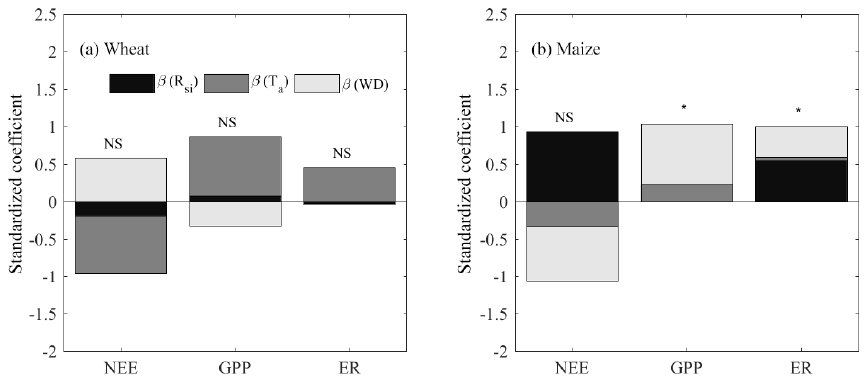
Figure 8. The result of multiple regression for NEE, GPP and ER with incoming shortwave radiation ( R si ), air temperature ( T a ) and ground- water depth (WD) for both (a) wheat and (b) maize. Note that ∗ denotes that the regression passes p < 0 . 05 significance level and that NS indicates nonsignificant.